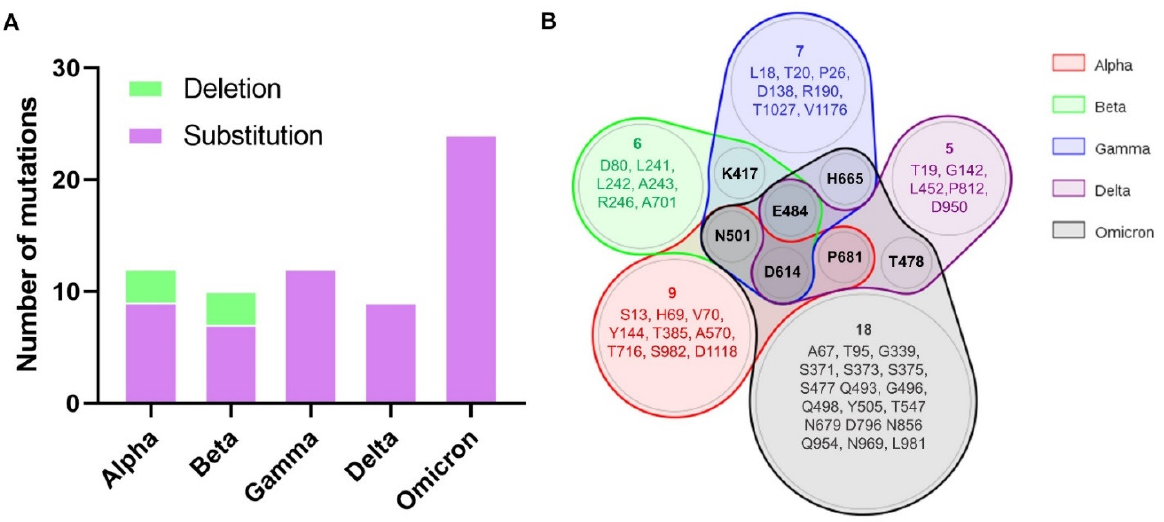
Figure 1. Mutations in spike glycoprotein. ( A ) Total number of mutations (Substitutions in pink and deletions in green) of each spike glycoprotein from SARS-CoV-2 variants; ( B ) Venn diagram showing the shared mutations (by residue position) between variants.